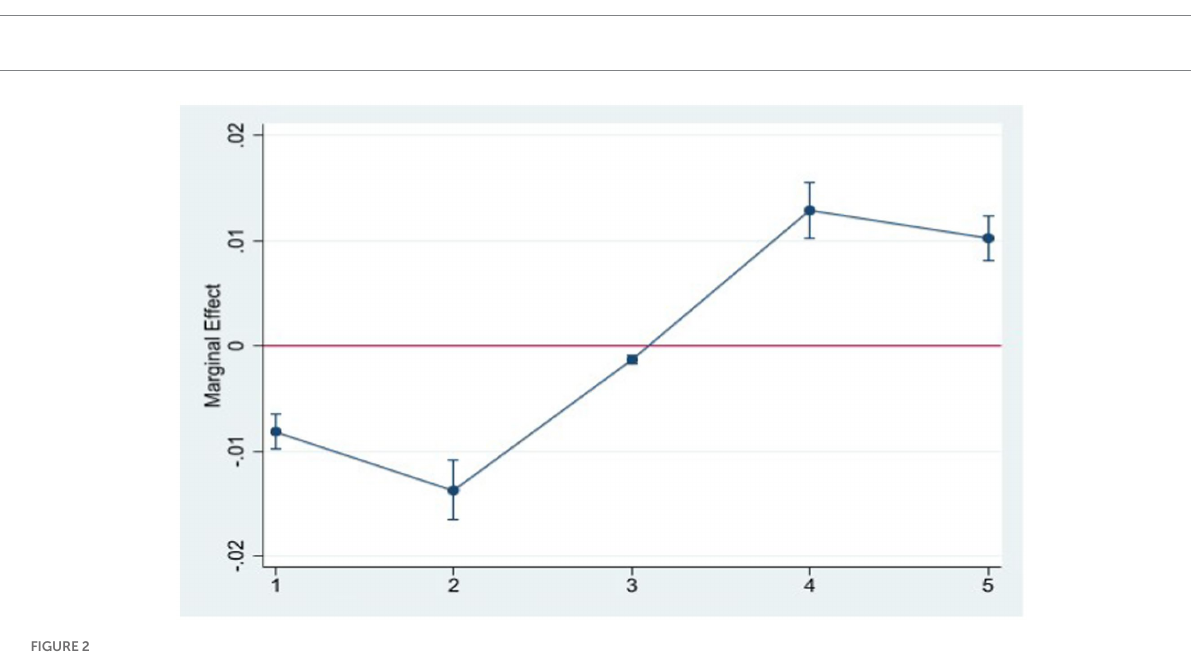
FIGURE 1 The effect of Internet use on life satisfaction.